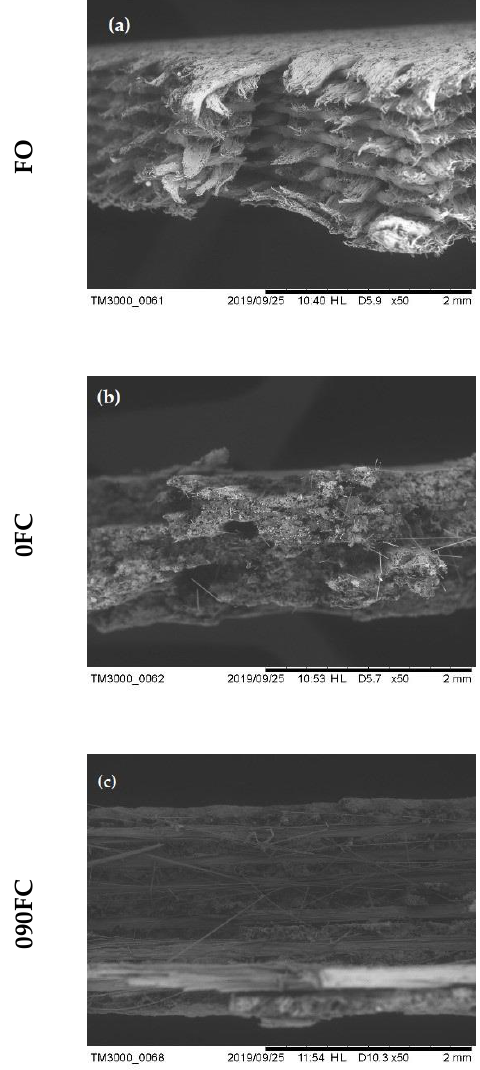
Figure 9. Pictures of tensile break mode of samples: ( a ) FO; ( b ) 0FC; and ( c )